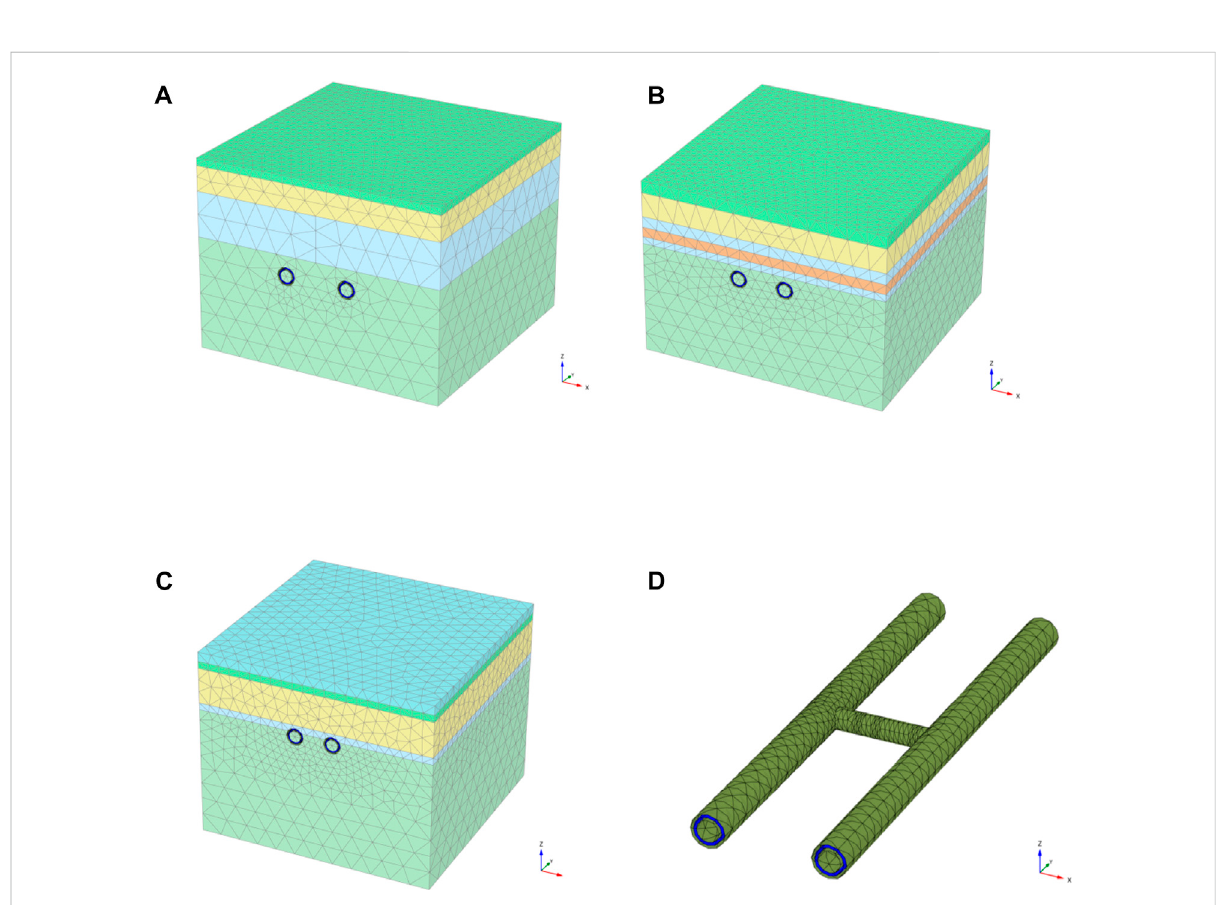
FIGURE 8 3D fi nite element model of the connecting aisle. (A) Model of connecting aisle No. 9. (B) Model of connecting aisle No. 10. (C) Model of connecting aisle No. 11 (D) Tunnel structure magni fi cation map of connecting aisle No.